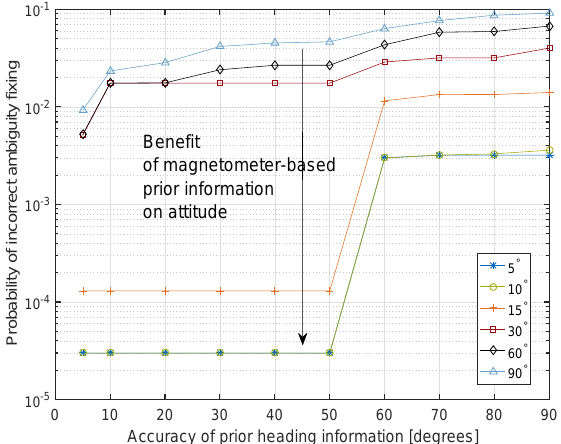
Figure 2. Benefit of magnetometer-based prior attitude information for single epoch integer ambiguity fixing: the accuracy of the prior heading information is shown on the x -axis and the accuracy of the prior pitch information is provided in the